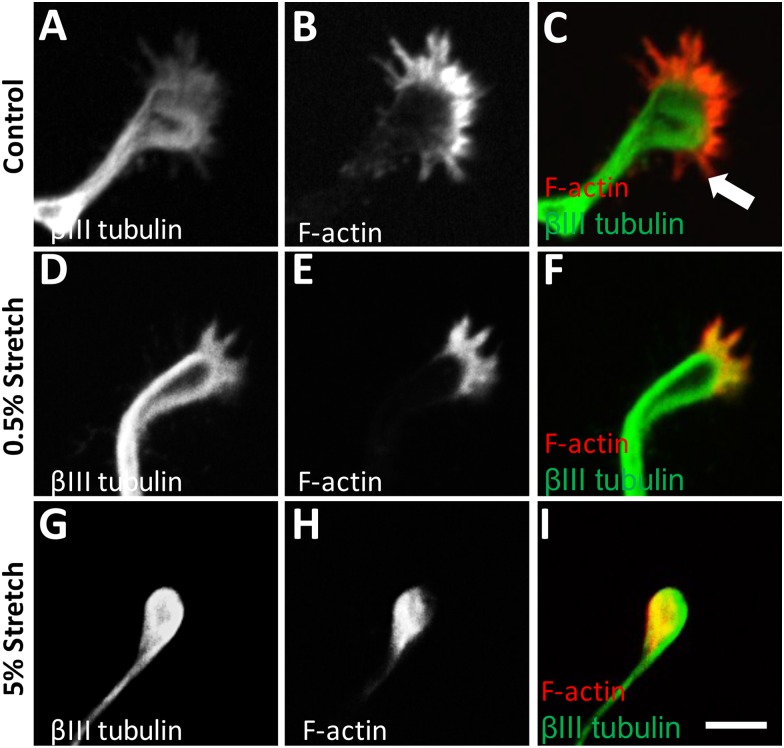
Immunocytochemistry images of growth cones of control (uninjured), 0.5% stretched and 5% stretched axons at 10 DIV and 72 h PI.(A-C) In the control, growth cones with distinct filopodia were apparent (arrow). The βIII tubulin labelling (green) was distributed predominantly within the central domain of the growth cone while F actin (red) was confined to the peripheral region. (D-F) In the 0.5% stretched axon, microtubules appeared to form a loop in the central region of the growth cones and F-actin was confined to the peripheral and transition region only. (G-I) In the 5% stretched axon, F-actin was most abundant in the axon tip, forming bulb like accumulations. Scale Bars = 10 μm.